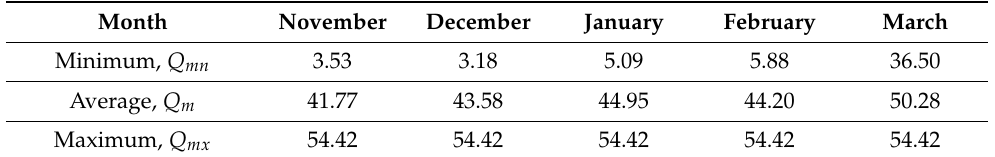
Table 3. Statistics of monthly averaged optimized recharge flow. Flows in km 3 /month from Novem- ber to March over 1993–2003 are derived from the surrogate model